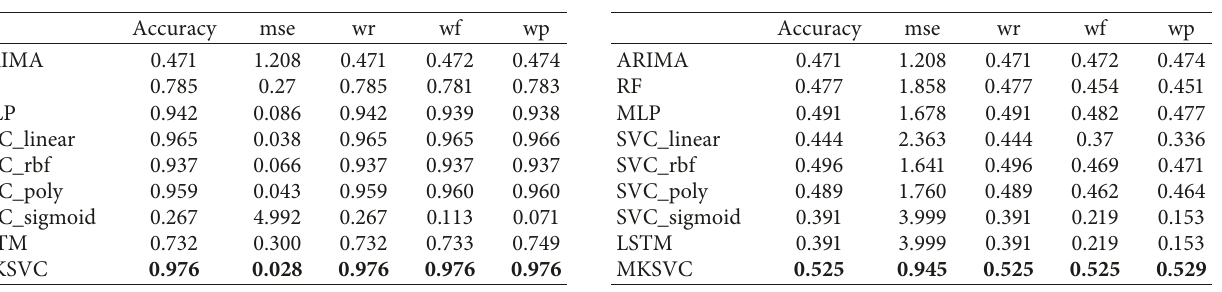
Table 9: Performance comparison for predicting the future 6 hour’s AQHI in HK.